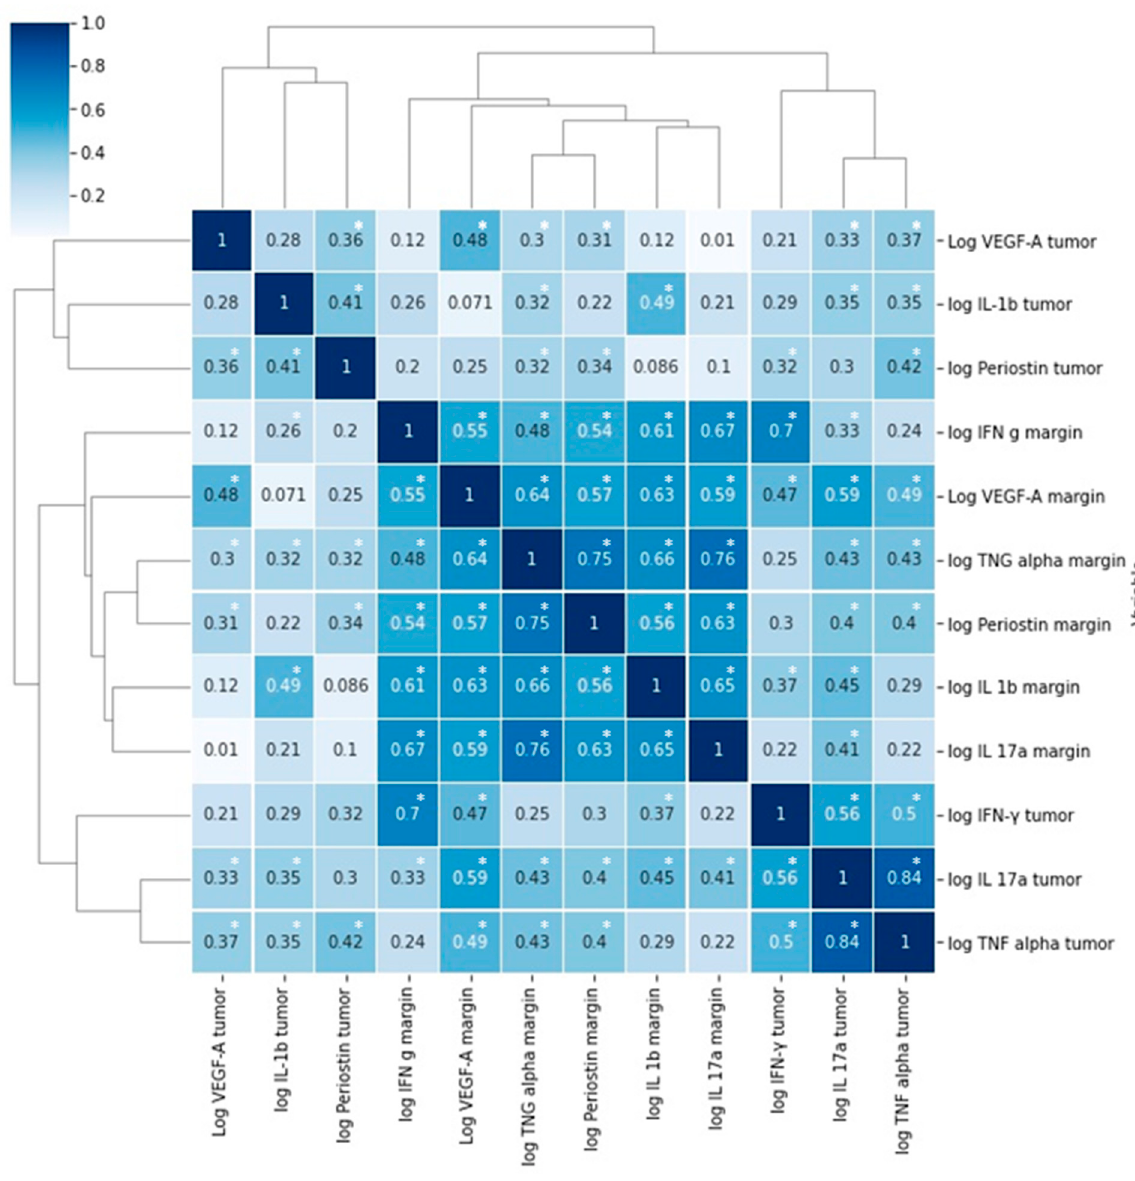
Figure 2. Correlations between the levels of the examined molecules presented as a heatmap with hierarchic clustering. R—Pearson’s correlation coefficient, * p < 0.05.